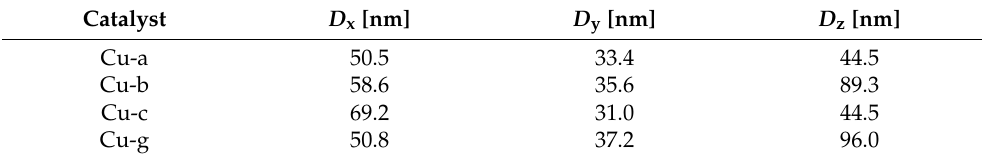
Table 3. Crystallite sizes in x-, y-, and z-direction relative to the unit cells for the CuO-60 catalysts. Catalyst D x